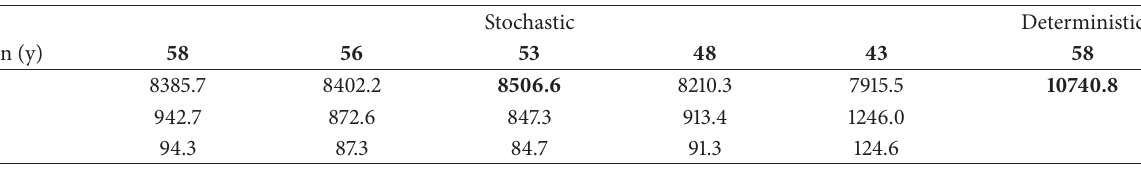
Table 2 indicates that the mean bare land values